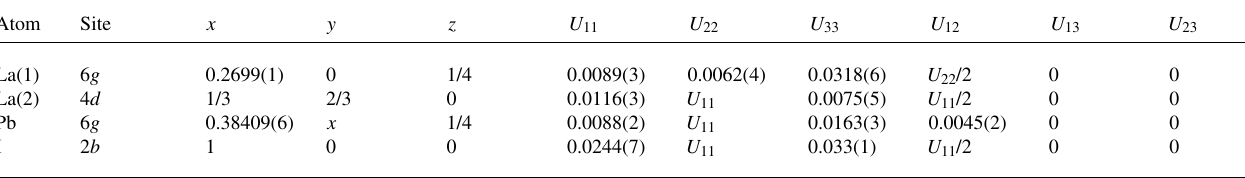
Table 2. Atomic coordinates and displacement parameters (in Å 2 )